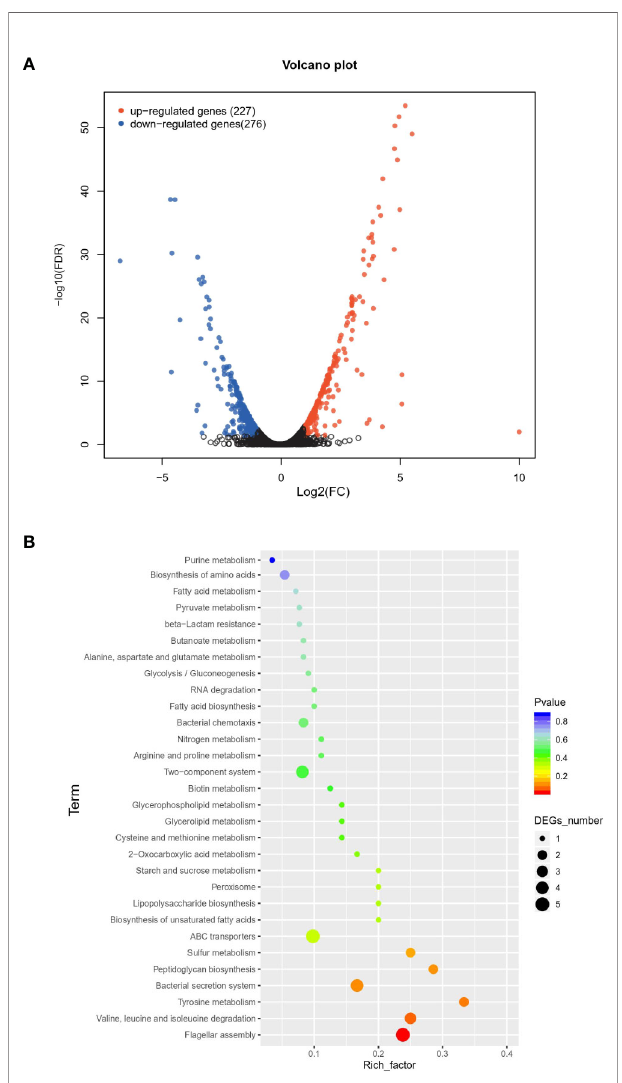
FIGURE 2 | The difference between wild type and mutant strain at the whole transcriptome level. (A) Volcano plot of differentially expressed genes (DEGs). In total, 503 unigenes present different expression levels. Red indicates upregulated expression, green indicates downregulated expression and blue indicates no signi fi cant differential expression when comparing. (B) Functional enrichment of differentially expressed genes on KEGG categorization in mutant